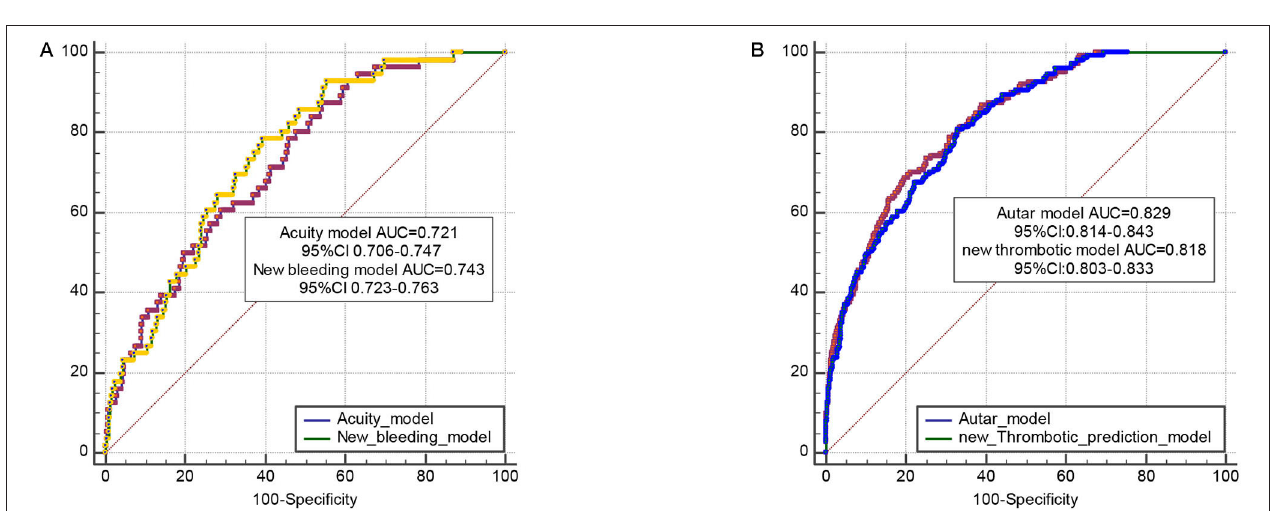
FIGURE 4 | (A) . Pairwise comparison of ROC curves between the new bleeding model and the acuity risk score model ( N = 3,976). The area under the ROC curve (AUC) of the new bleeding model is 0.743 [confidence interval (CI)0.723–0.763], and the AUC of acuity score is 0.721 (CI.706–0.747). P = 0.4047, z statistic, 0.833. (B) . Pairwise comparison of ROC curves between the new thrombotic model and the autar risk score model ( N = 3,976). The AUC of new the thrombotic model is 0.818 (CI.803–0.833), and the AUC of acuity score is 0.829 (0.814–0.843). p = 0.1079, z statistic,